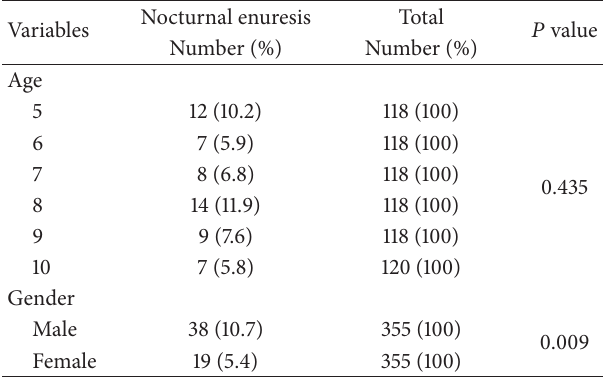
Table 1: Prevalence of nocturnal enuresis in primary school chil- dren in Khorramabad in terms of age and